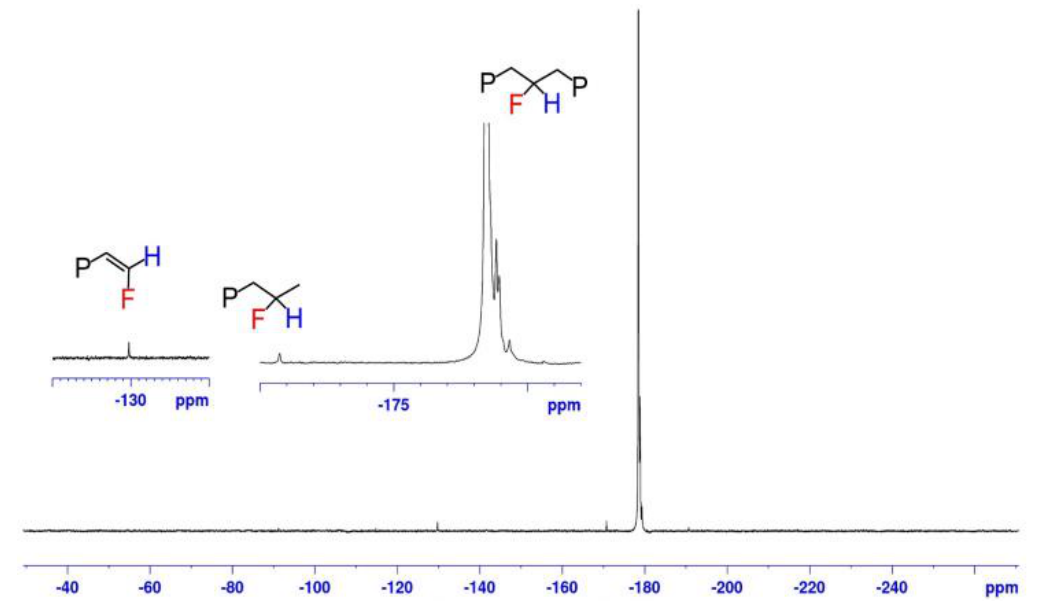
Figure 3. 19 F{ 1 H} NMR spectrum of ethylene / VF copolymer ( o -dichlorobenzene- d 4 , 120 ◦ C) produced by C (Table 1, entry 4).